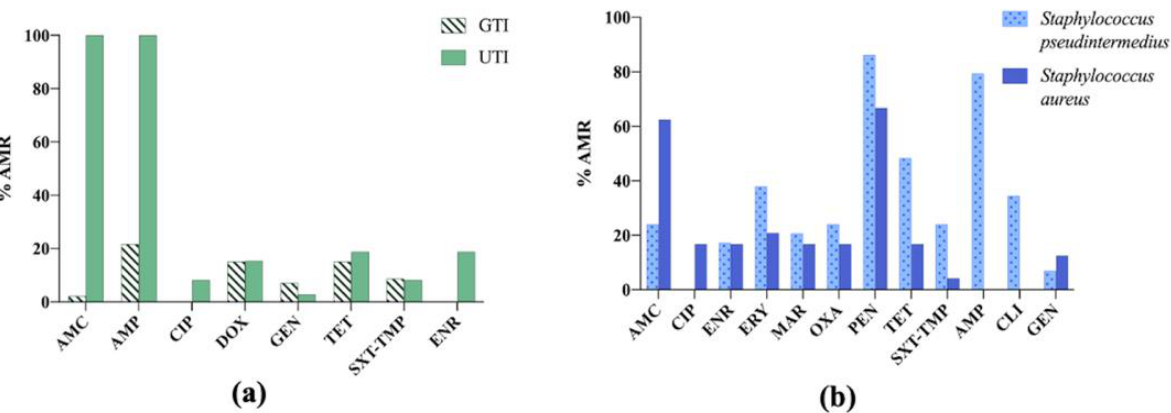
Figure 6. ( a ) Antimicrobial resistance (AMR) prevalence in Escherichia coli isolated from dogs and cats in Germany. GTI: gastrointestinal tract infections; UTI: urinary tract infections; AMC: amoxicillin– clavulanic acid; AMP: ampicillin; CIP: ciprofloxacin; DOX: doxycycline; GEN: gentamicin; TET: tetracycline; SXT-TMP: sulfamethoxazole – trimethoprim; ENR: enrofloxacin. ( b ) Antimicrobial re- sistance (AMR) prevalence in Staphylococcus pseudintermedius and Staphylococcus aureus isolated from dogs in Germany. AMC: amoxicillin – clavulanic acid; CIP: ciprofloxacin; ENR: enrofloxacin; ERY: erythromycin; MAR: marbofloxacin; OXA: oxacillin; PEN: penicillin; TET: tetracycline; SXT-TMP: sulfamethoxazole – trimethoprim; AMP: ampicillin; CLI: clindamycin; GEN: gentamicin.